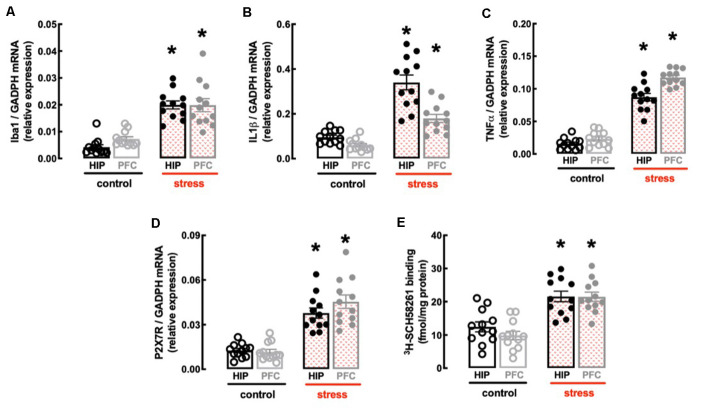
Male adult Wistar rats (8–10 weeks old) subject to a protocol of restraint stress (4 h/day) during 14 days display an increased expression of inflammatory markers and an up-regulation of P2X7 and A2A receptors in the hippocampus (black) and prefrontal cortex (gray). Compared with non-stressed control rats (open bars), stressed rats (red checkered bars) displayed an increased expression of the microglia marker Iba1 (A), of interleukin 1β (IL1β; B), of tumor necrosis factor α (TNFα; C), and P2X7 receptors (P2X7R; D) as well as an increased density of A2A receptors (A2AR; E) as assessed by the binding density of a supramaximal concentration of the selective A2AR antagonist 3H-SCH58261 (2 nM). Data are shown as mean ± SEM; n = 11–12 rats per group. *P < 0.001 vs. control using a Student’s t-test.